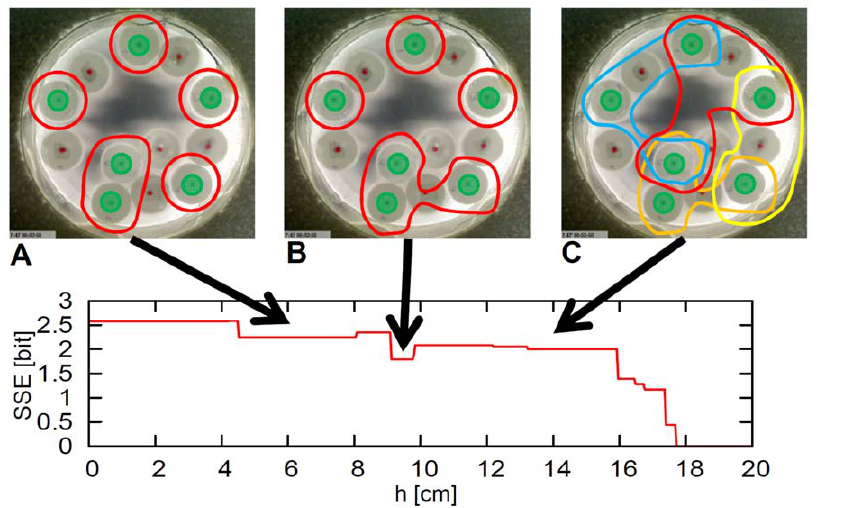
Figure 13. Schematics explaining how to calculate the SSE and the HSE. The figure shows the example from the certain configuration (certain timestep) of the passive elements in the circular case. A. The elements are grouped with h ~ 6 into five subgroups. B. The elements are grouped with h ~ 9 : 6 into four subgroups. C. The elements are grouped with h ~ 14 into four overlapped subgroups.